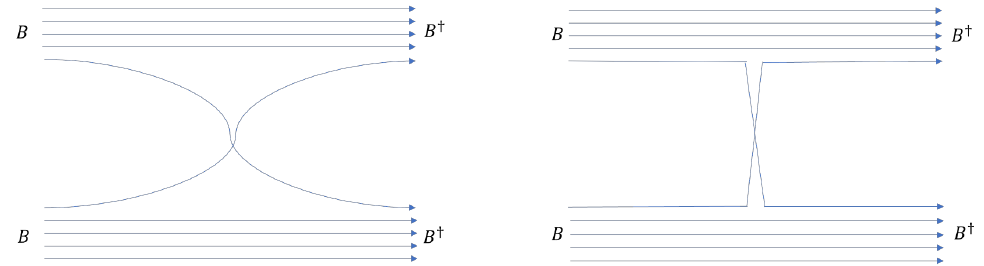
Figure 3 . Leading 4-baryon diagrams. On the left diagram the baryons exchange a quark without any interactions. The choice of colour gives a factor of N . On the right diagram the baryons exchange a gluon. The choice of colour now gives a factor of N 2 , the gluon propagator and two vertices give 1 /N , resulting again in a total factor of N